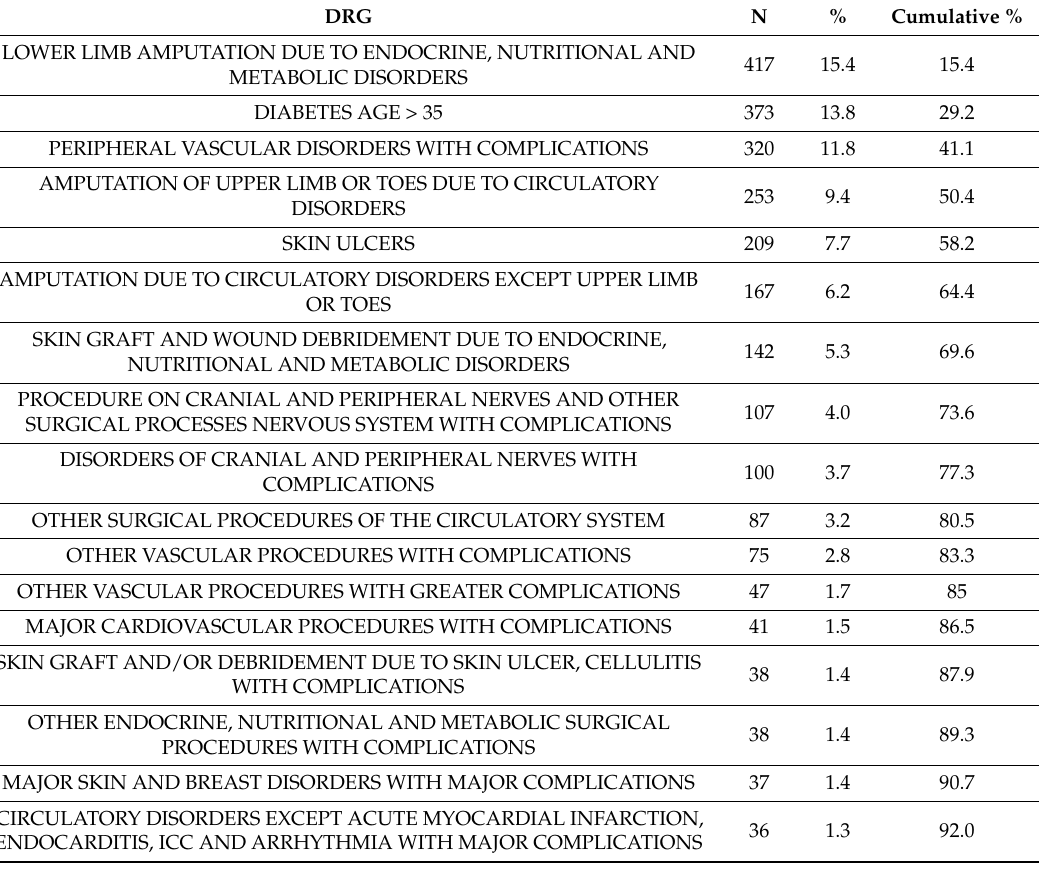
Table 2. Health care admissions by DRG.